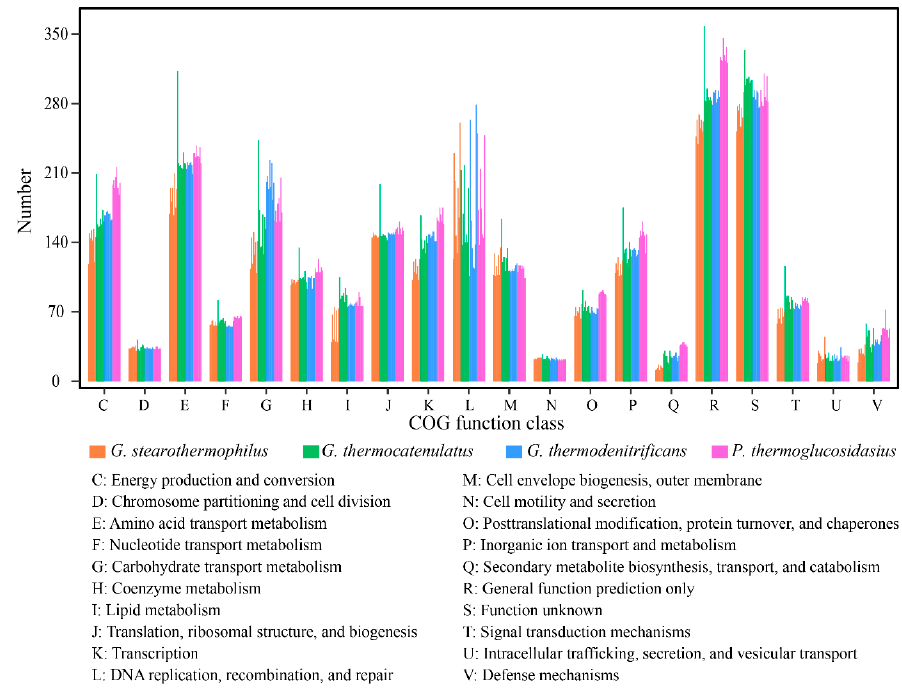
Figure 1. Comparisons of COG functional categories of G. stearothermophilus , G. thermocatenulatus , G. thermodenitrificans , and P. thermoglucosidasius . For each category, from left to right are strain ATCC 12980 T , B5, Sah69, 53, B4109, C1BS50MT1, D1, DSM 458, BCO2, GS-1, DSM 730 T , KCTC3921, SURF-114, SURF-48B, SURF-189, T6, DSM 465 T , ID-1, NG80-2, PA-3, JSC-T9a, KCTC3902, OS27, T12, C56-YS93, DSM 2542 T , GT23, ZCTH02-B4, TG4, TNO-09.020, W-2, and Y4.1MC1. Int. J. Mol. Sci. 2020 , 21 , x FOR PEER REVIEW